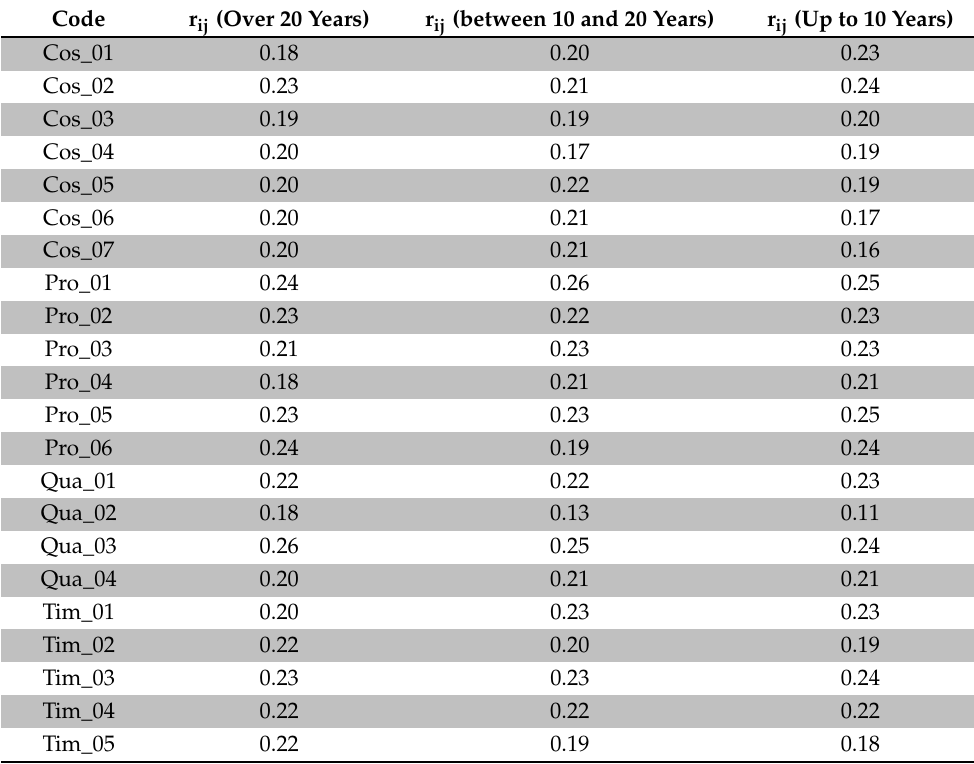
Table 3. R matrix with normalized values. Source: